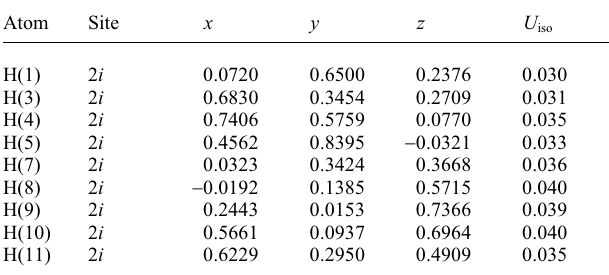
Table 2. Atomic coordinates and displacement parameters (in Å 2 ) .